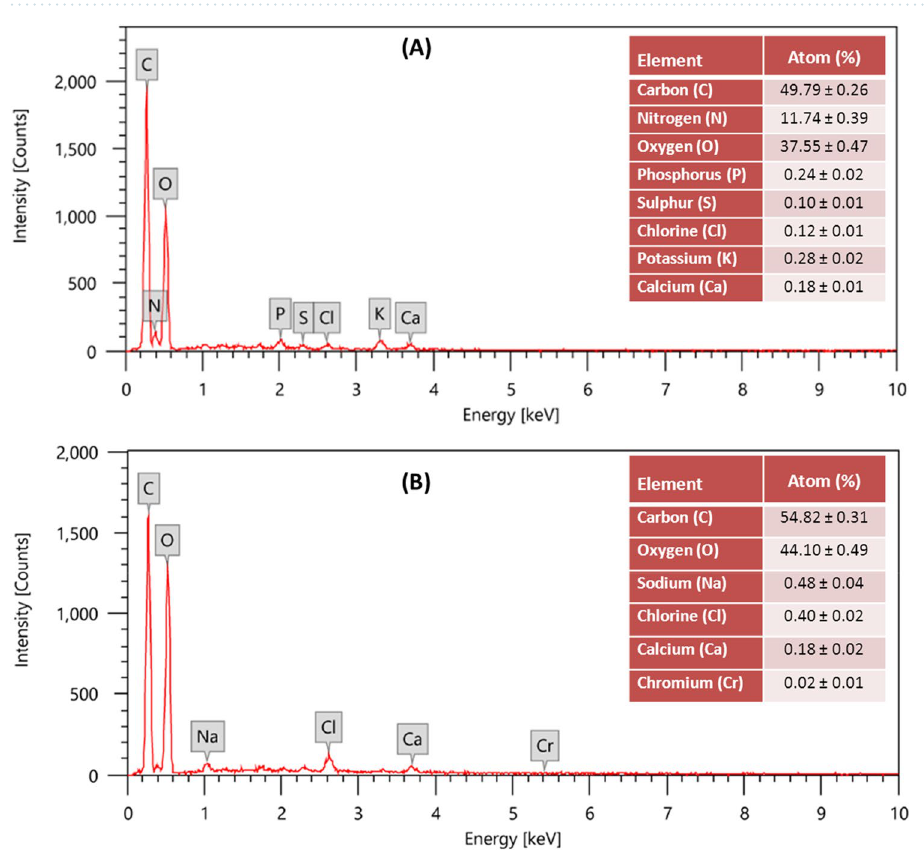
Figure 4. EDX spectra of S. rochei ANH control biomass (A) and Cr 6+ -treated biomass (B)